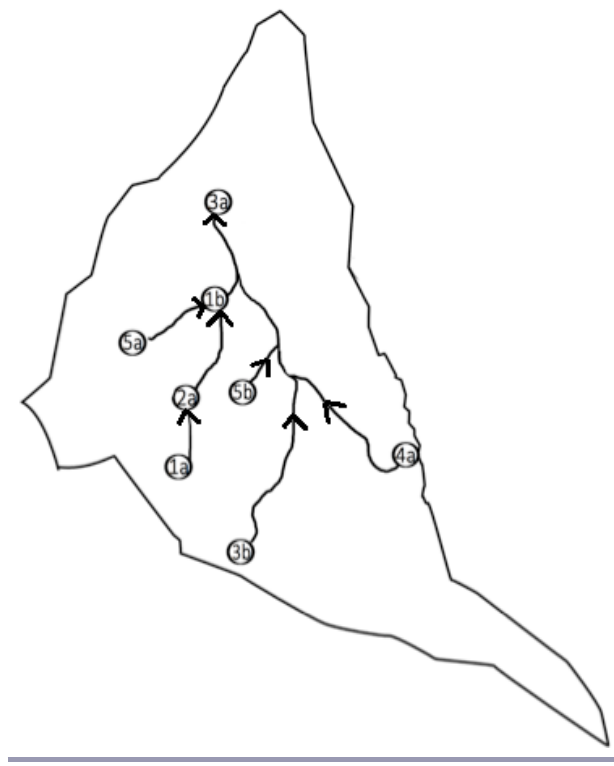
Fig. 2 . The model used to connect plots and, by extension, individuals to one